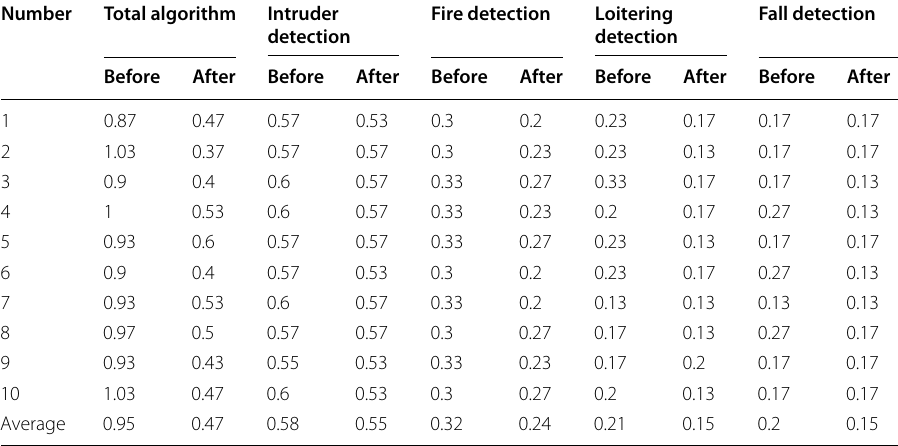
Table 5 Comparison of performance before and after optimization of embedded module Number Total algorithm Intruder Fire detection Loitering Fall detection detection detection Before After Before After